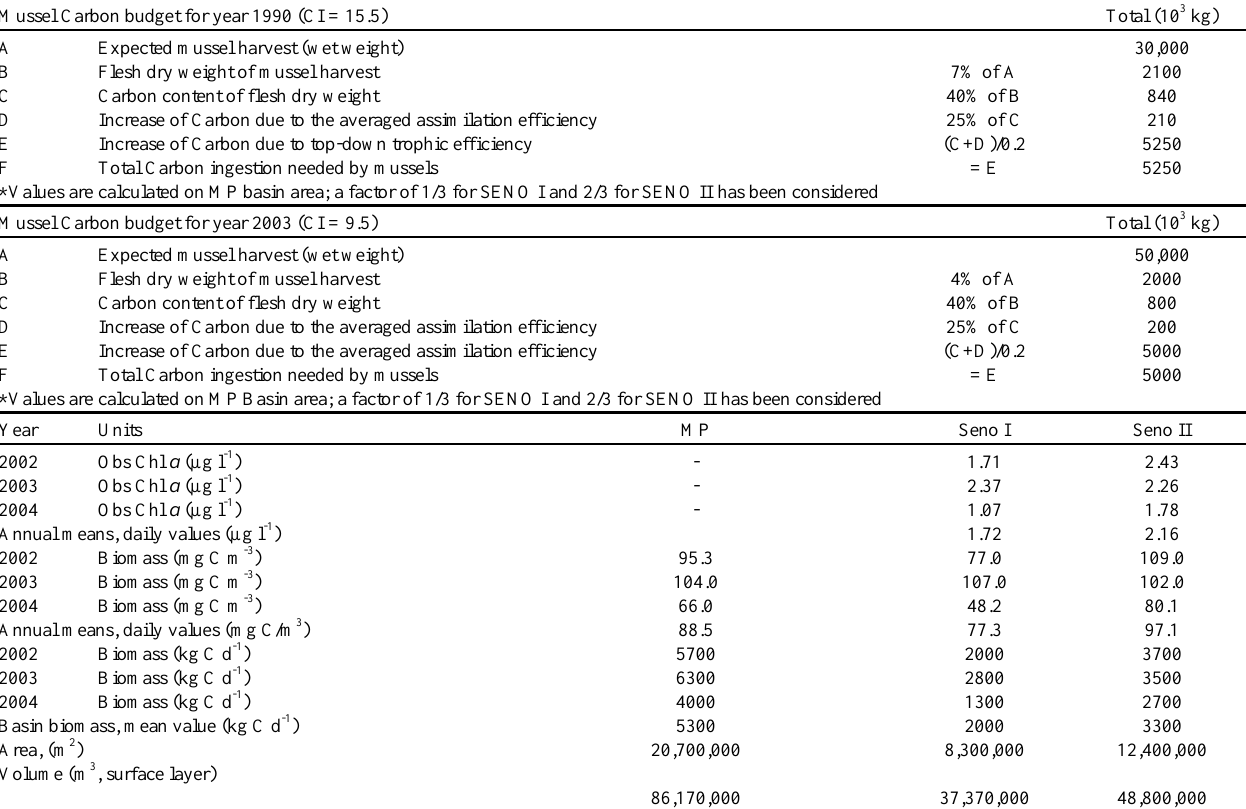
Table 3 . Top-down calculations of mussel carbon budget for the mean expected harvest (ignoring seed stock) expressed as wet weight for two different trophic scenarios: years 1990, 2003. Values have been calculated by considering as a proxy the 1990 mussels physiological data, e.g., flesh dry weight % and carbon content. Globally, the carbon ingestion needed by mussels (F) is estimated as the sum of the carbon content of flesh dry weight (C, values from Brigolin et al. 2009), and the increase of carbon due to mean assimilation efficiency (D), both multiplied by the top-down trophic efficiency from mussels to phytoplankton (E, from Teramoto 1993, Townsend et al. 2000). In the lower part of the table the values of observed chlorophyll a converted to biomass (ratio Chl:C = 45) from year 2002 to year 2004 (simulation period) are reported to quantify the available biomass in each